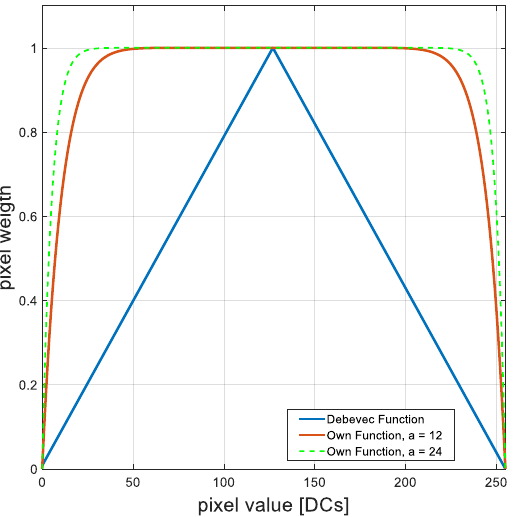
Figure 3. Comparison of weighting functions. Original triangular function [41] and our own function w ( z ), with b = 8 and a = 12 and 24.